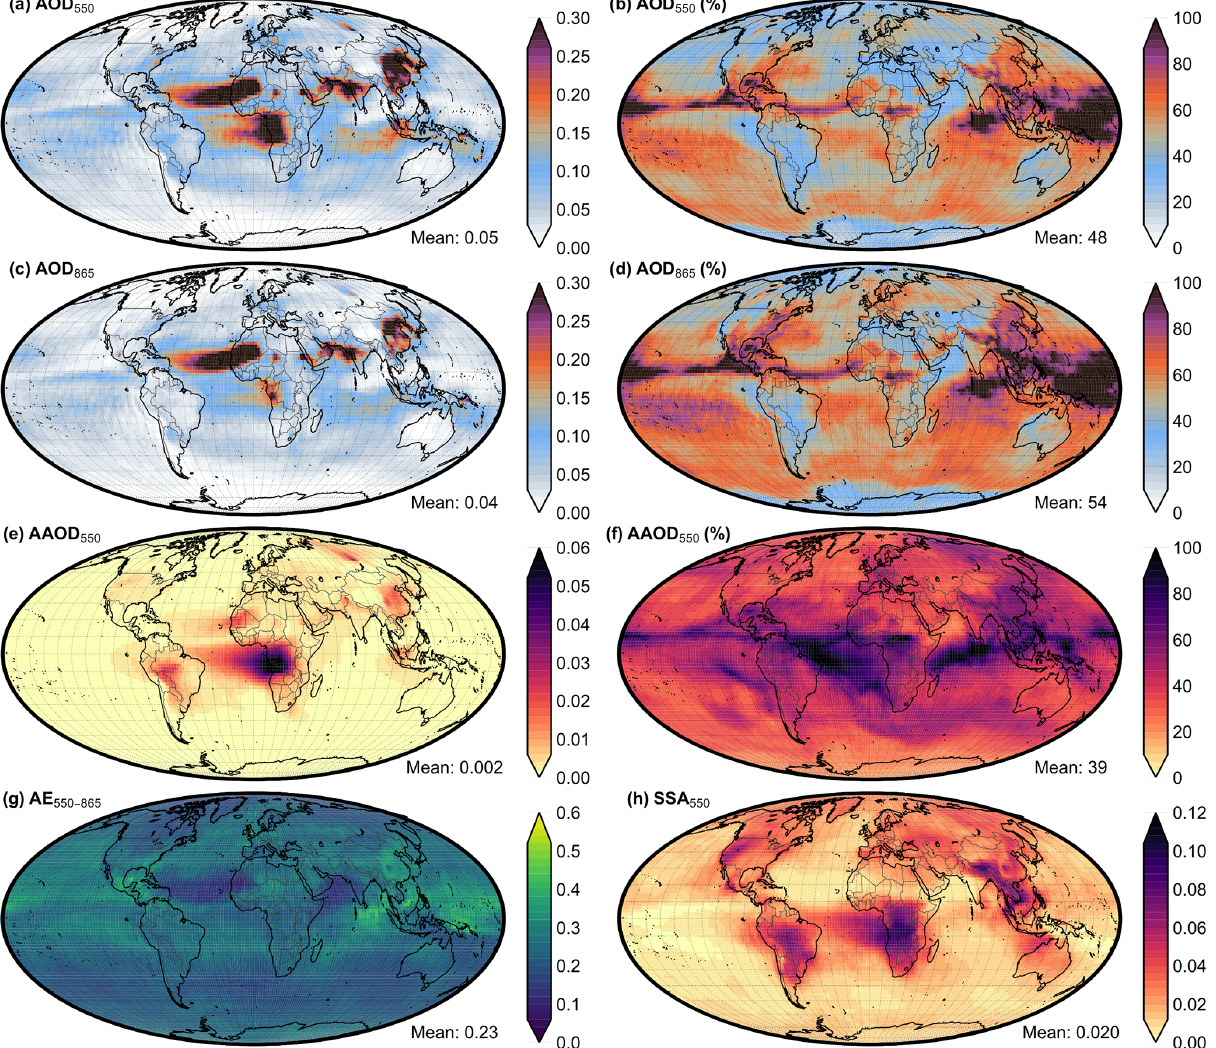
Figure 3. The uncertainty and the relative uncertainty of ECHAM-HAM for AOD 550 (a, b) AOD 865 (c, d) and AAOD 550 (e, f) and the uncertainty for AE 550 − 865 (g) and SSA 550 (h) averaged over the period 20 July to 28 August 2006. The uncertainty is estimated using the SD of an ensemble (32 members) where each member used different spatial correlated perturbations on aerosol emissions and wind. The relative uncertainty is defined as the ratio of SD to mean. The global mean of each variable is denoted in the bottom-right corner for each case.